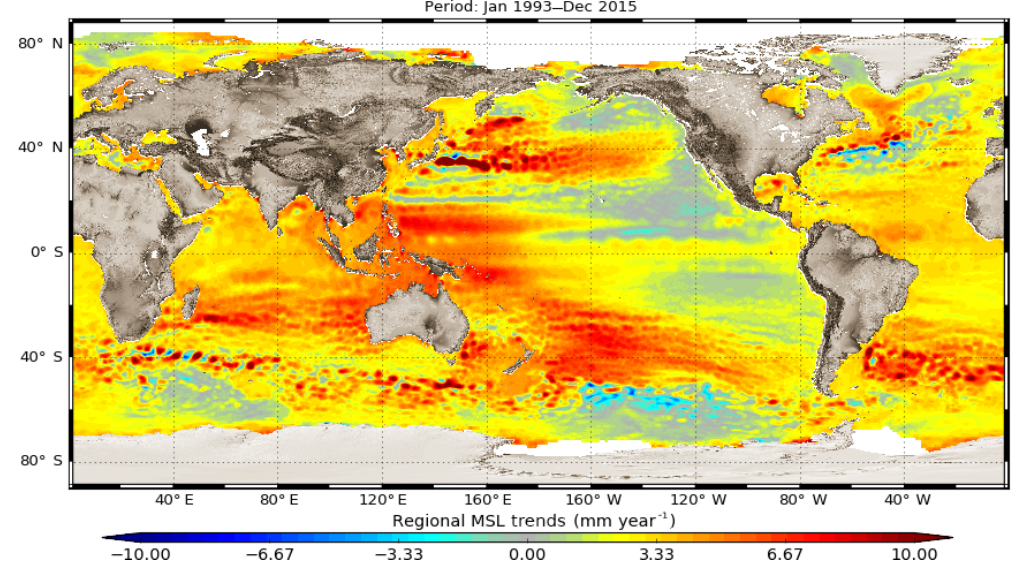
Figure 2. Regional MSL trend (from SL_cci v2.0 ECV) during the period 1993–2015.